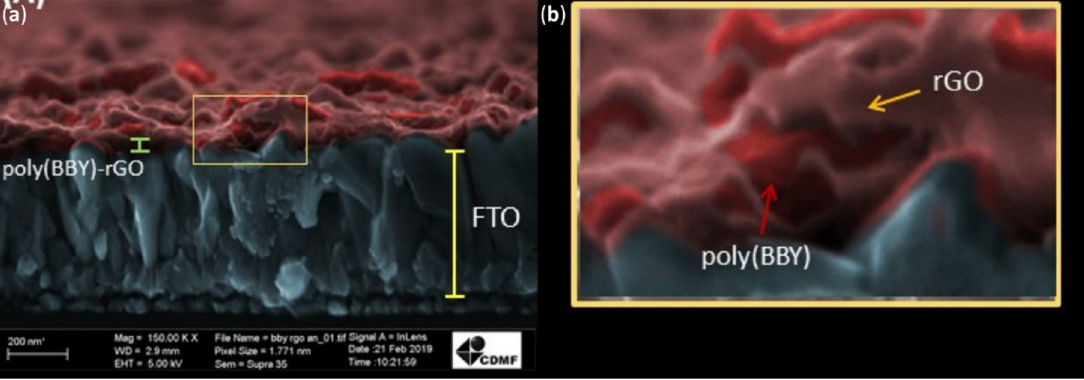
Figure 25. ( a ) SEM cross section image of poly(azo-BBY)-rGO film under FTO recorded at 150,000× magnification. ( b ) magnified view of the FTO-poly(azo-BBY)-rGO interfacial area highlighted in yellow box. The SEM images were artificially colored [120].